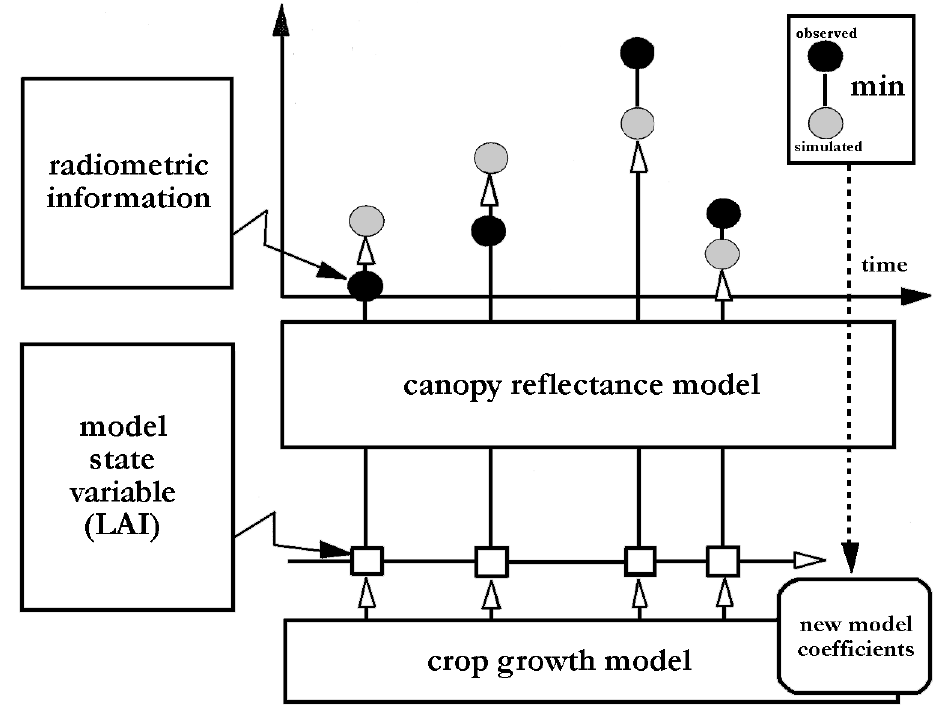
Figure 8. Schematic description of the re-calibration method using radiometric information as inputs. The crop growth model simulates the leaf development ( LAI ) over time. This information is used to simulate the canopy reflectance using an appropriate canopy reflectance model. In the non-linear minimization procedure, new model coefficients are assigned to the crop growth model such that the residues between observed and simulated